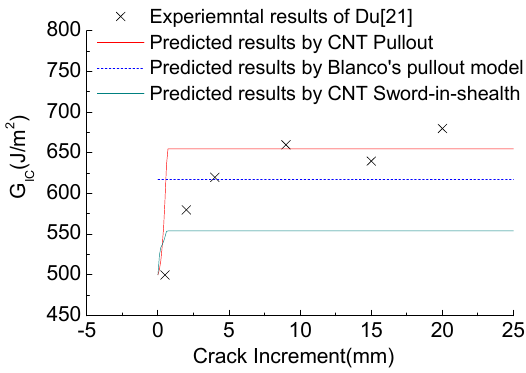
Figure 6. Comparison between predicted and experimental results for toughness models.